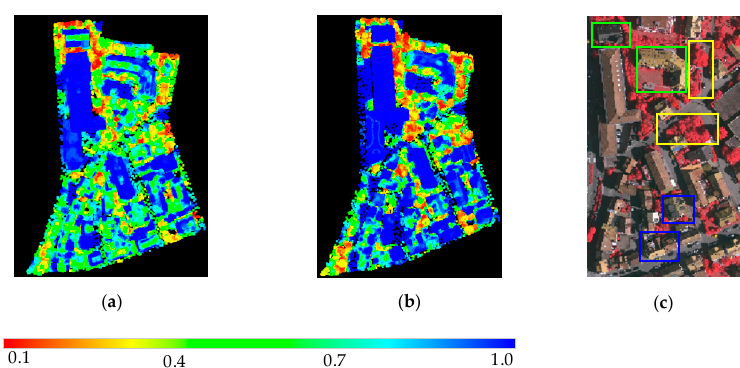
Figure 3. Visualization of f v (rendered by the value of normalized f v ). ( a ) f v of [12]; ( b ) the proposed f v ; ( c ) Orthophoto.